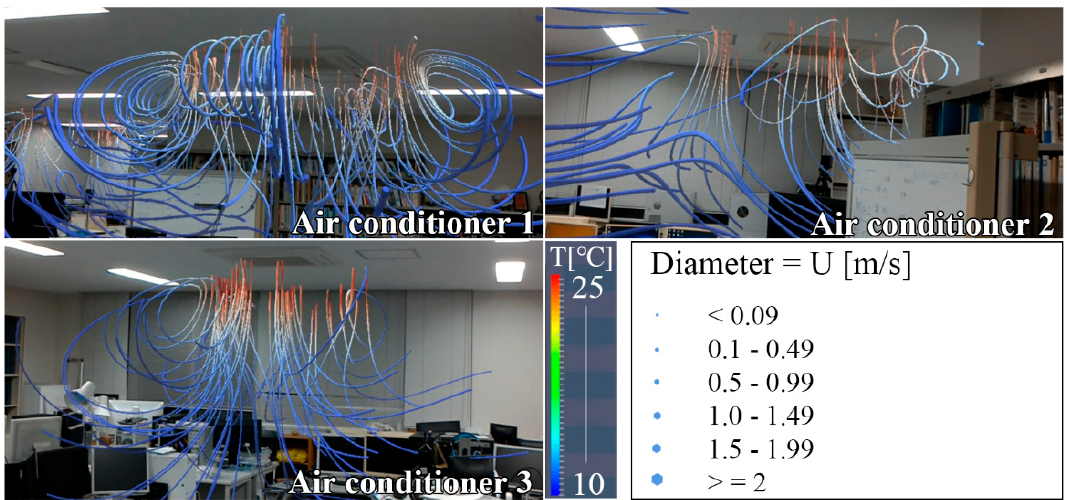
Figure 2. Thermal environment performance in the head-mounted display (HMD).